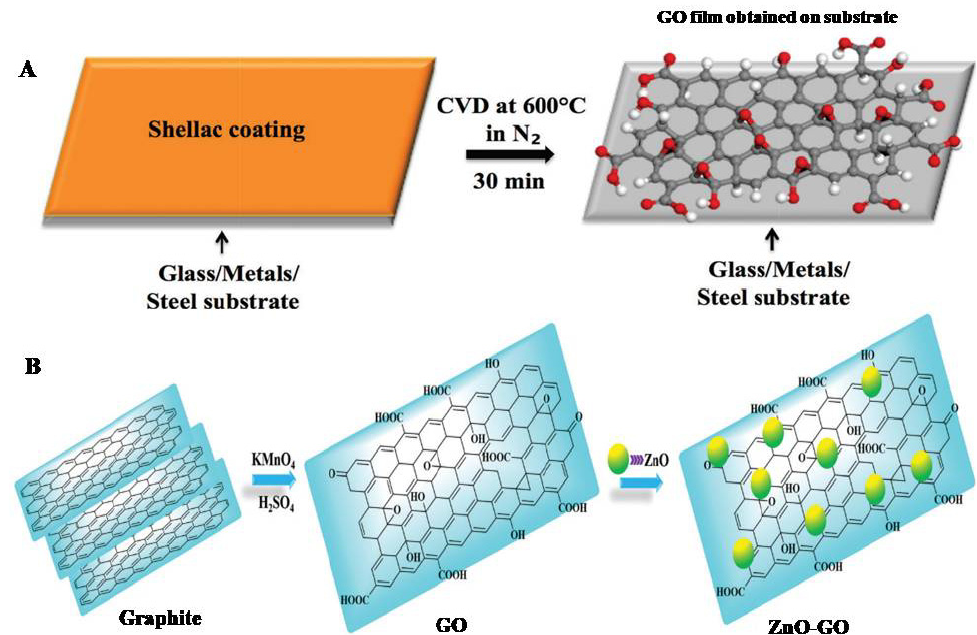
Figure 2. ( A ) Schematic diagram showing synthesis of GO directly on various substrates from natural biopolymer shellac. GO film is shown in ball and stick model; red: oxygen atom, gray: carbon atom, white: hydrogen atom. The shellac-coated substrates were heated at 600 °C under nitrogen atmosphere for 30 min to synthesize GO directly on different substrates [52]. ( B ) The possible mechanism of the transformation of graphite to GO and then to ZnO/GO NC [53]. Reprinted/adapted with permission from Refs. [52,53]. Copy right 2018, copyright Willey-VCH. Copy right 2020, copyright